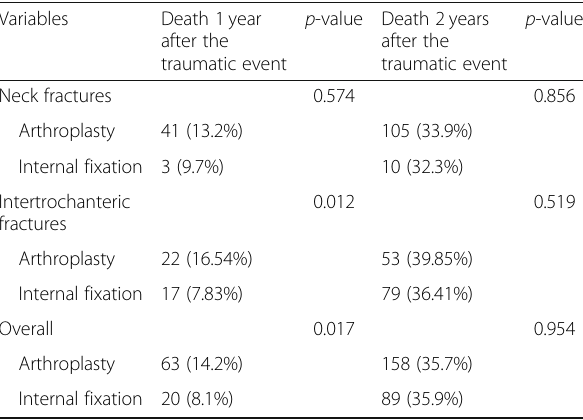
Table 3 Mortality rates of surgical techniques 1 and 2